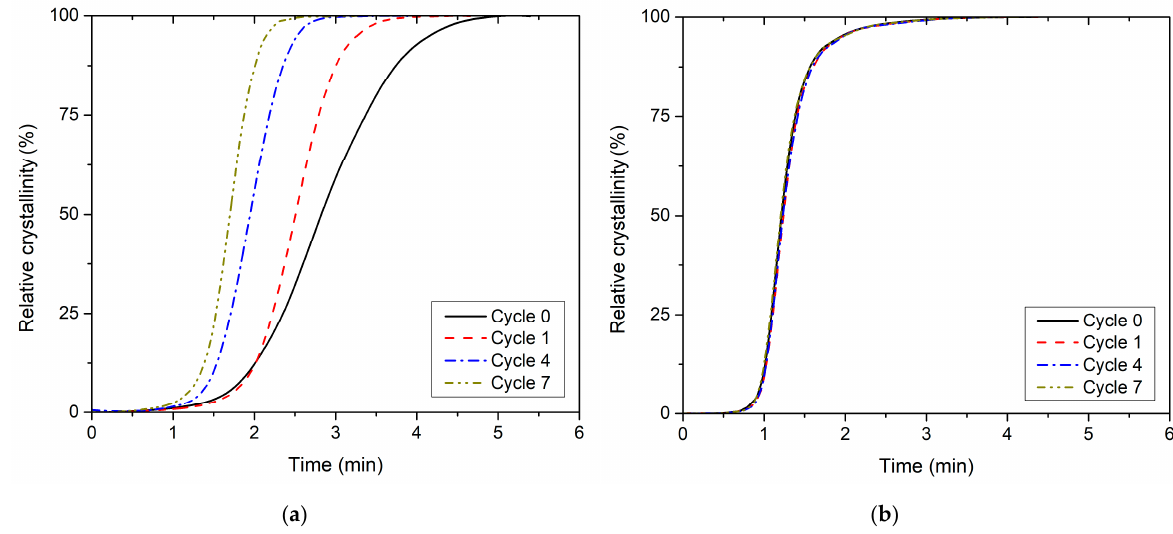
Figure 6. Relative crystallinity versus time for non-isothermal melt crystallisation ( a ) PLLA and ( b ) PHBV at cooling rate 10 ◦ C/min. Table 4. Crystallisation half-time ( t 0.5 ), crystallisation starting temperature ( T S ), inflection point temperature ( T i ), relative crystallinity at the inflection point ( X Ti ), and maximum crystallisation rate ( s i ) during melt crystallisation of PLLA and PHBV as a function on the number of recycling cycles (cooling rate: 10 ◦ C/min).